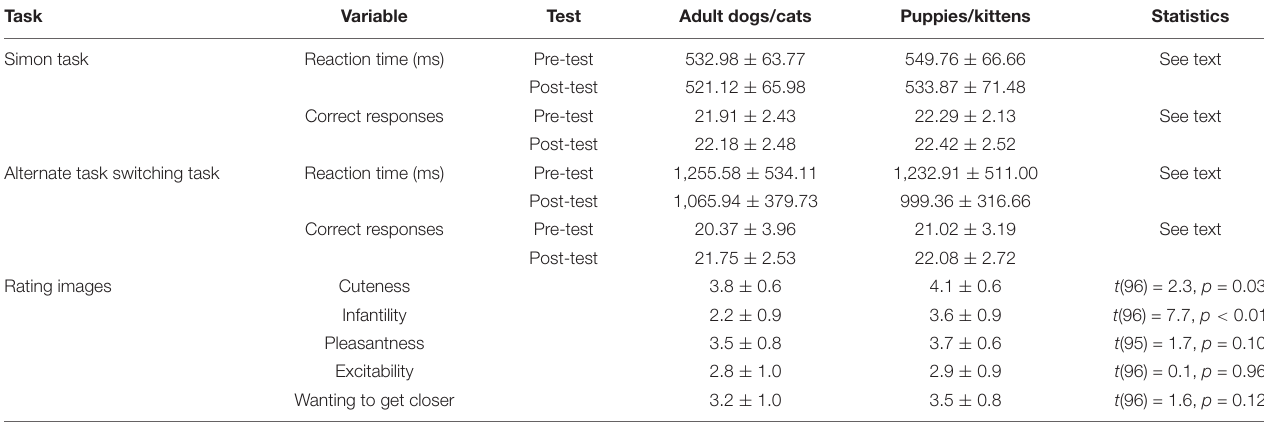
TABLE 2 | Reaction times, correct responses, and ratings of the seven images of adult dogs/cats and the seven images of puppies/kittens of the participants in the main